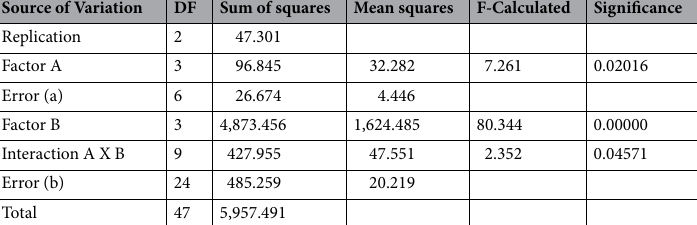
Source of Variation DF Sum of squares Mean squares F-Calculated